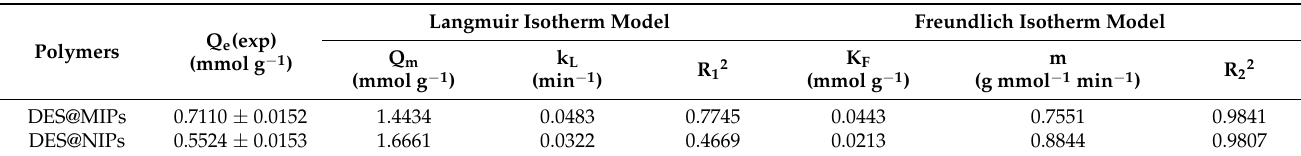
Table 3. Parameters of Langmuir equation and Freundlich equation.